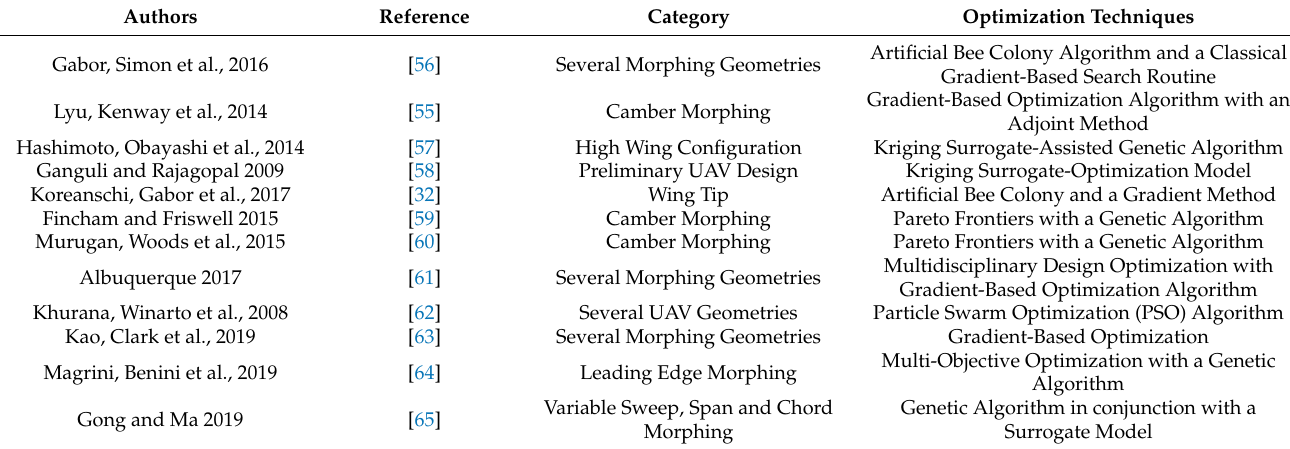
Table 1. Airfoil optimization research carried out by using different